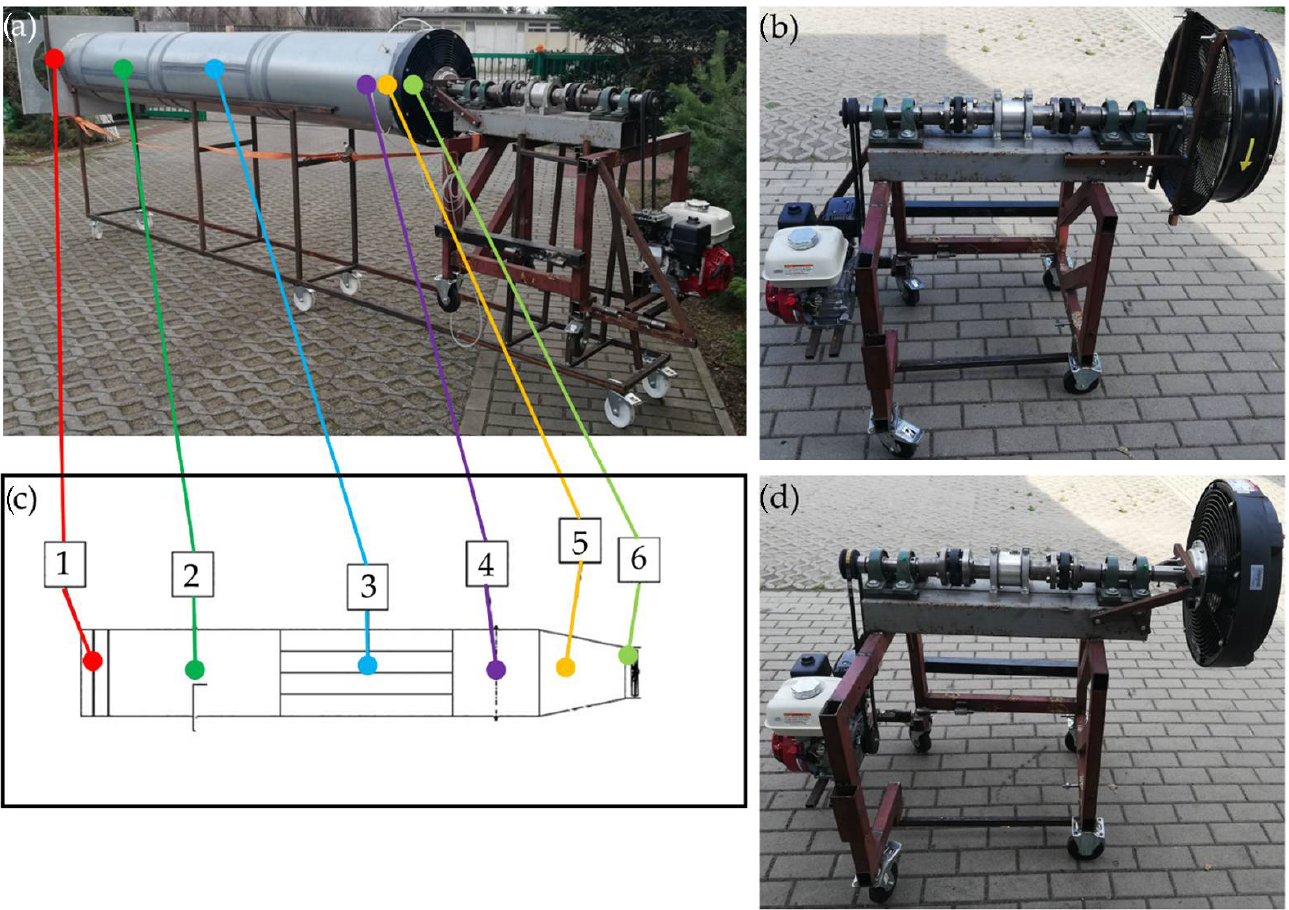
Figure 3. Mobile positive pressure fans during testing: ( a ) Method A (fan W1); ( b ) Method B (fan W1); ( c ) diagram of the measuring duct position in Method A, where 1—flow throttling section, 2—measurement area of static and dynamic pressure flow, 3—flow straightener, 4—static pressure measurement section (four-point ring), 5—duct confusor to match the fan impeller dimensions to the test duct diameter, and 6—fan positioning area; ( d ) Method B (fan W2).